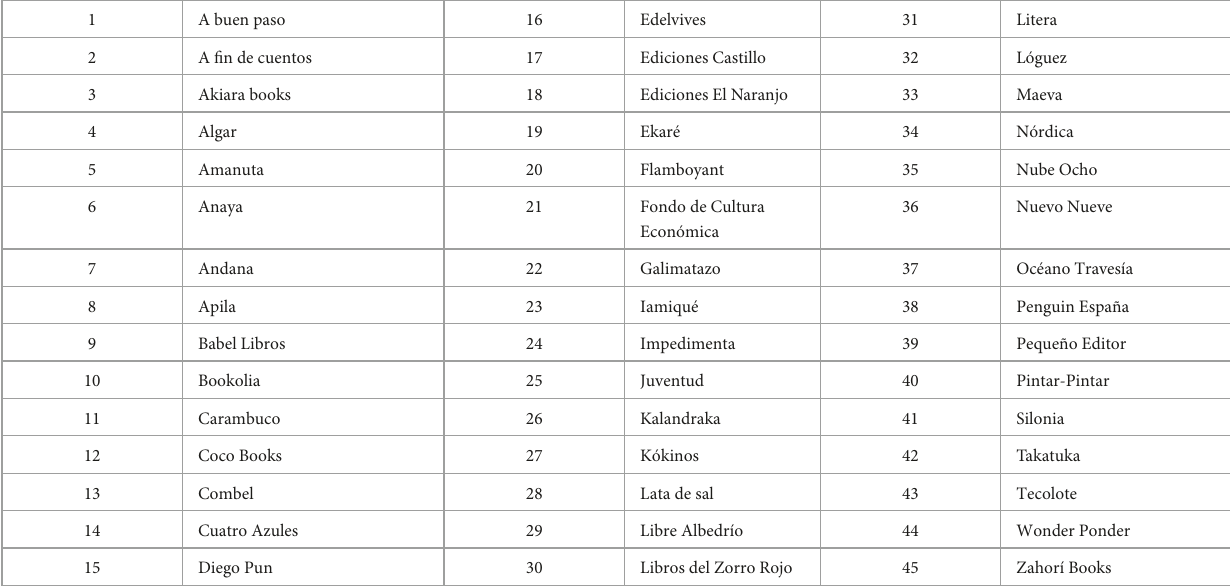
TABLE 2 Publishers in the study